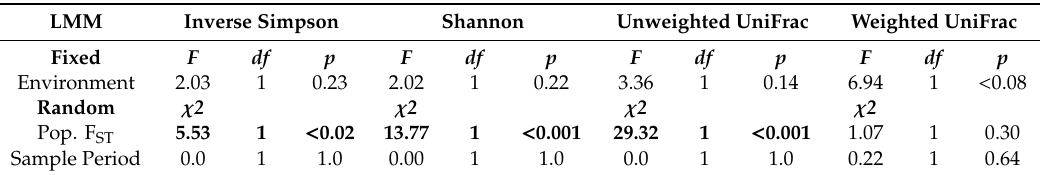
Table 4. Linear mixed model (LMM) statistics results. Results with p -value ≥ 0.05 in bold. Guts rarefied to even depth of 1000 amplicon sequences variants (ASVs) per sample.